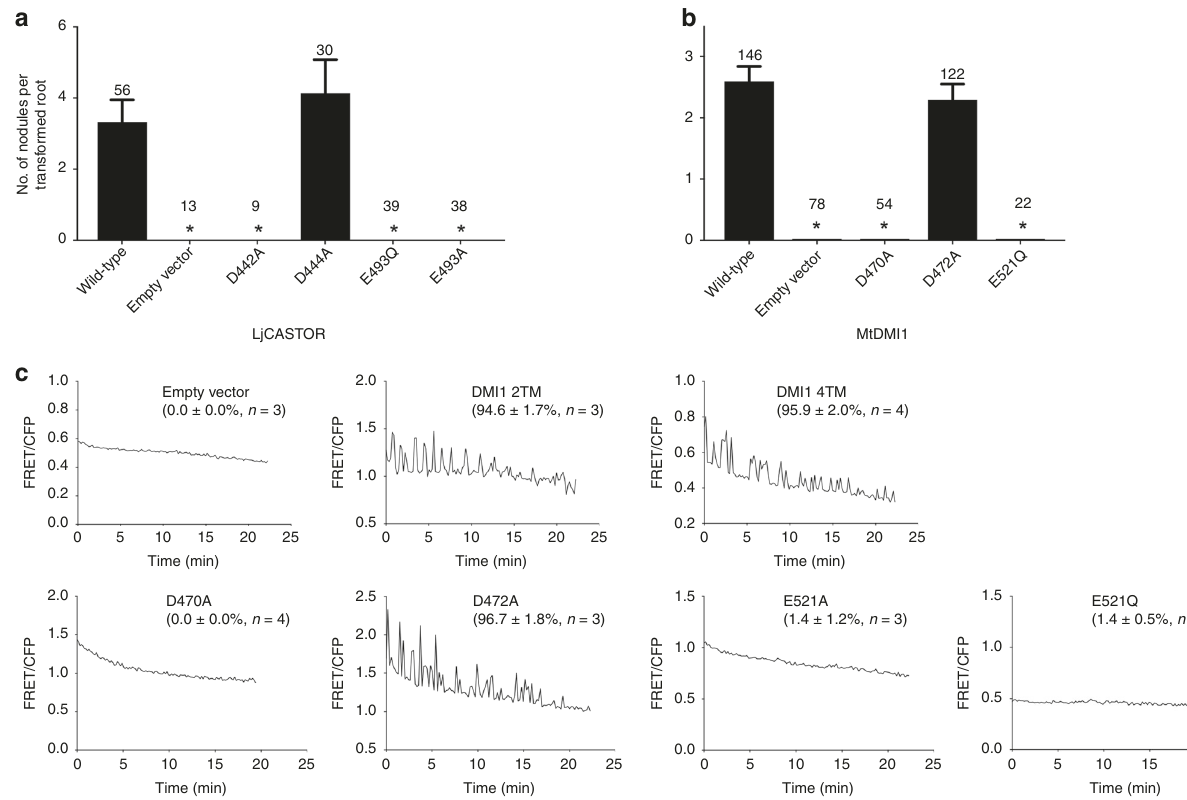
Fig. 7 Functional importance of gating ring Ca 2 + binding. a Nodulation assay for LjCASTOR and its Ca 2 + site mutants expressed in CASTOR-null L. japonicus ; the number above the error bar indicates the number of roots tested; *, p < 3.1 × 10 − 4 . b Nodulation assay for MtDMI1 and its Ca 2 + site mutants expressed in DMI1-null M. truncatula ; *, p < 2.6 × 10 − 6 . c Representative recordings of calcium spiking in HEK 293 cells transfected with full-length MtDMI1 and its variants or MtDMI1-2TM. The numbers in the parenthesis are the population ratios of the cells that were positive in Ca 2 + spiking (mean ± s.e.m. in percentage and n is the number of